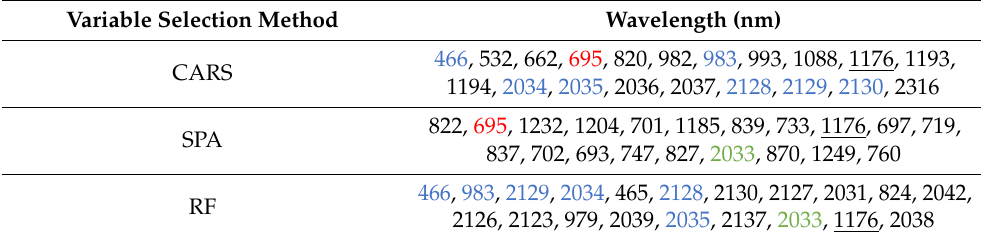
Underlined values indicate commonly shared wavelengths for all variable selection methods; red values indicate shared wavelengths for CARS and SPA; blue values indicate shared wavelengths for CARS and RF; green values indicate shared wavelengths for SPA and RF.